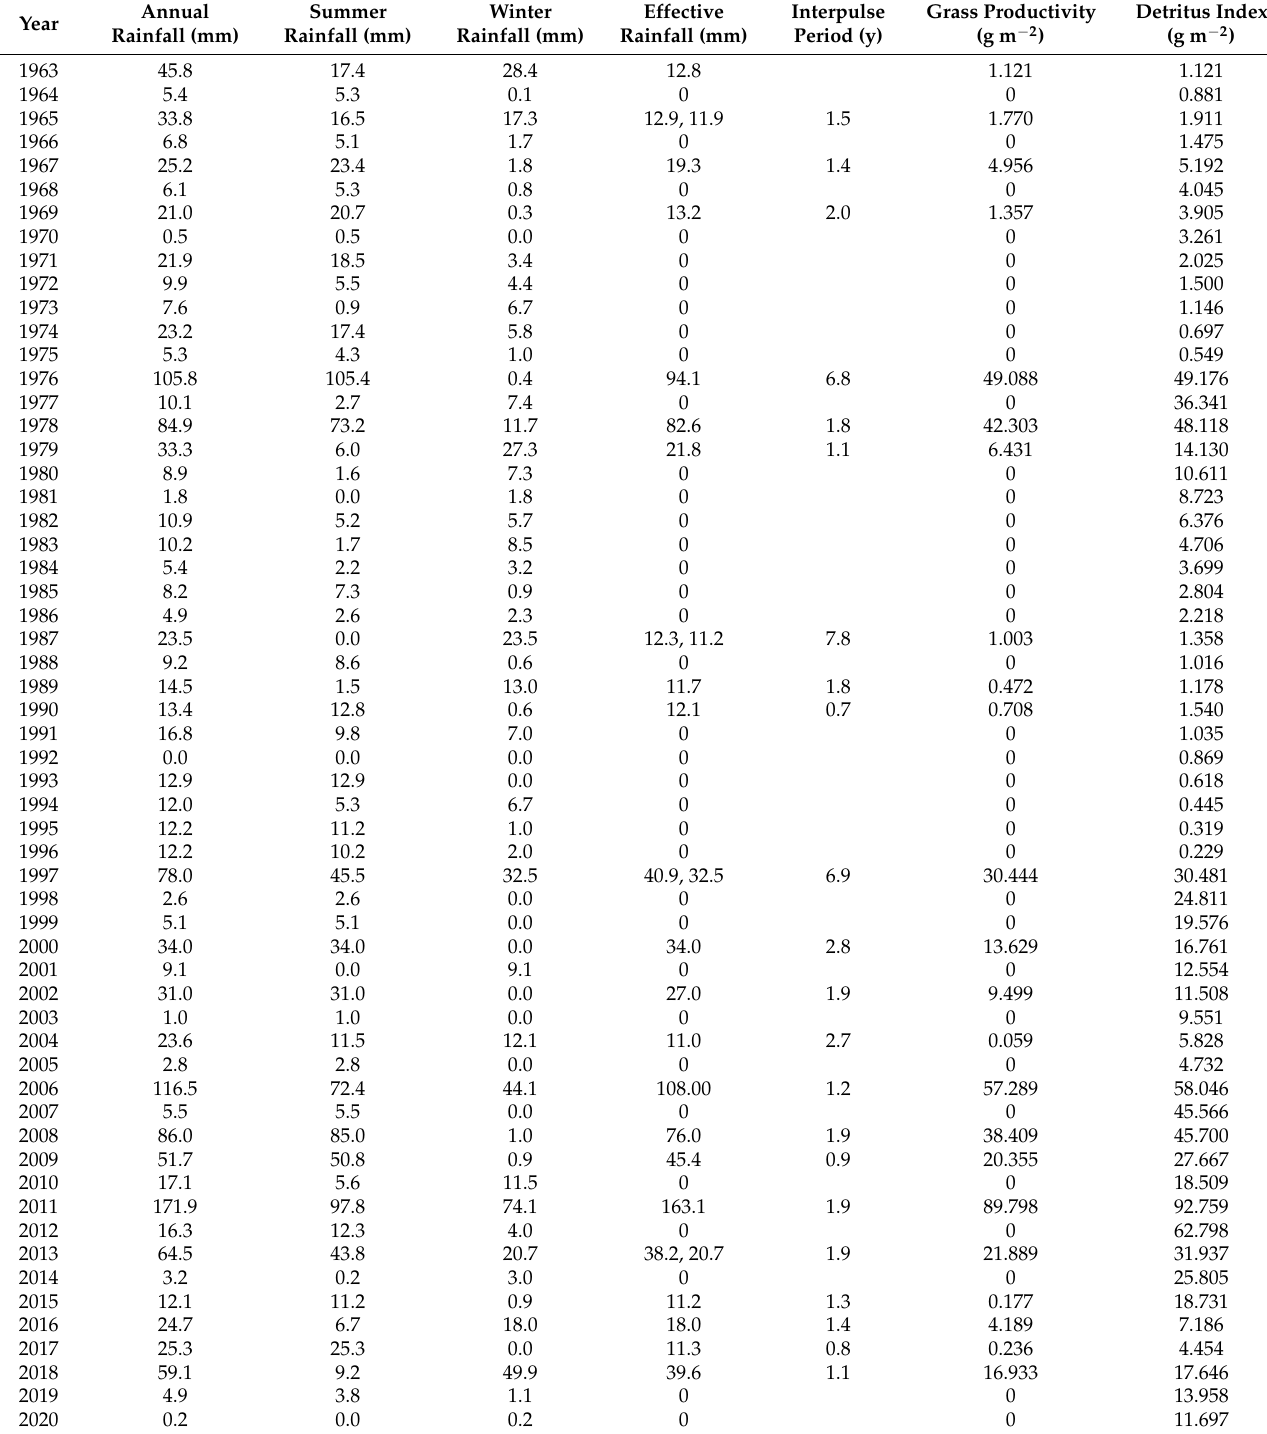
Table A1. Annual rainfall at Gobabeb between 1963–2020, summer (October to March) and winter (April–September) rainfall, amounts, and intervals between effective rainfall events, calculated grass productivity generated by these events, and the amount of detritus calculated from productivity and decay